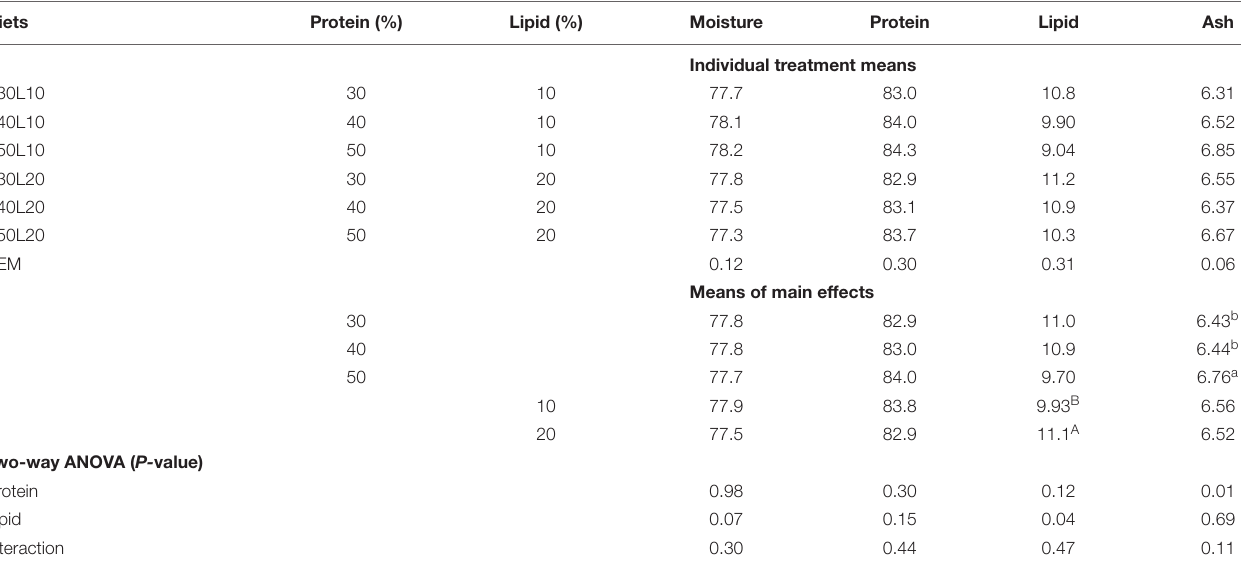
Diets Protein (%) Lipid (%) Moisture